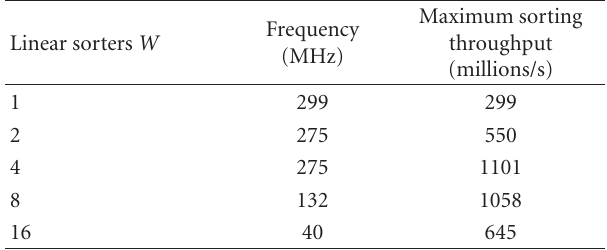
Table 6: ILS frequency and